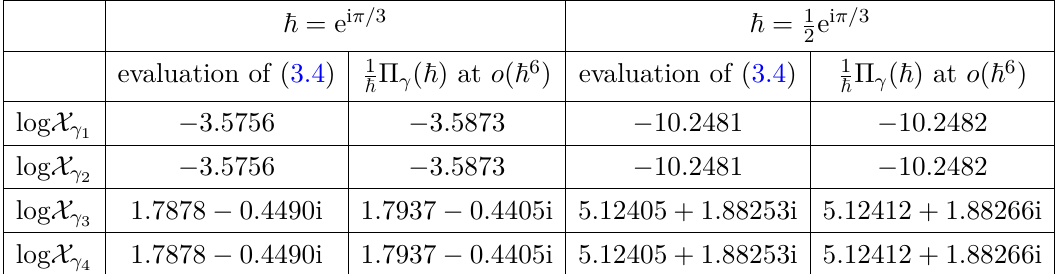
Table 2 . Comparison of log X γ with the formal quantum periods expansion up to order- ~ 6 at ~ = e i π/ 3 and ~ = 1 e i π/ 3 for equation A of (1.12), where we have set u 2